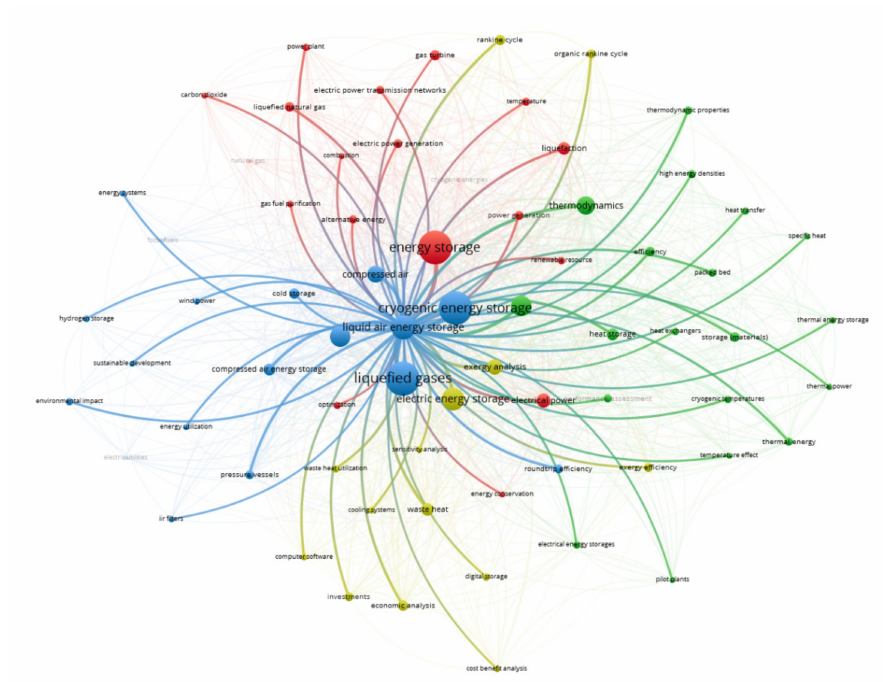
Figure 14. Co-occurrence and link of the keyword “liquid air energy storage” elaborated with VOSviewer.